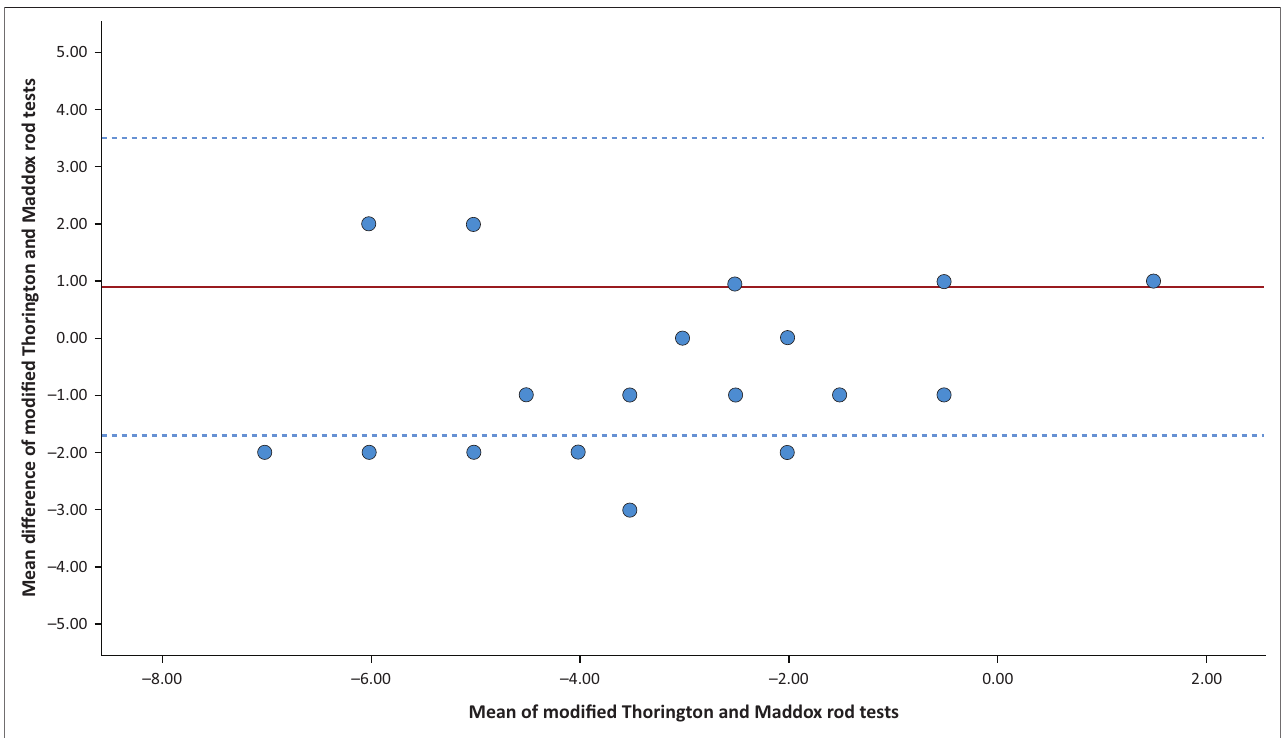
FIGURE 4: Bland–Altman plot showing the agreement between modified Thorington test and Maddox rod test. Although most points are within the limits of agreement, there are several points outside the 95 %